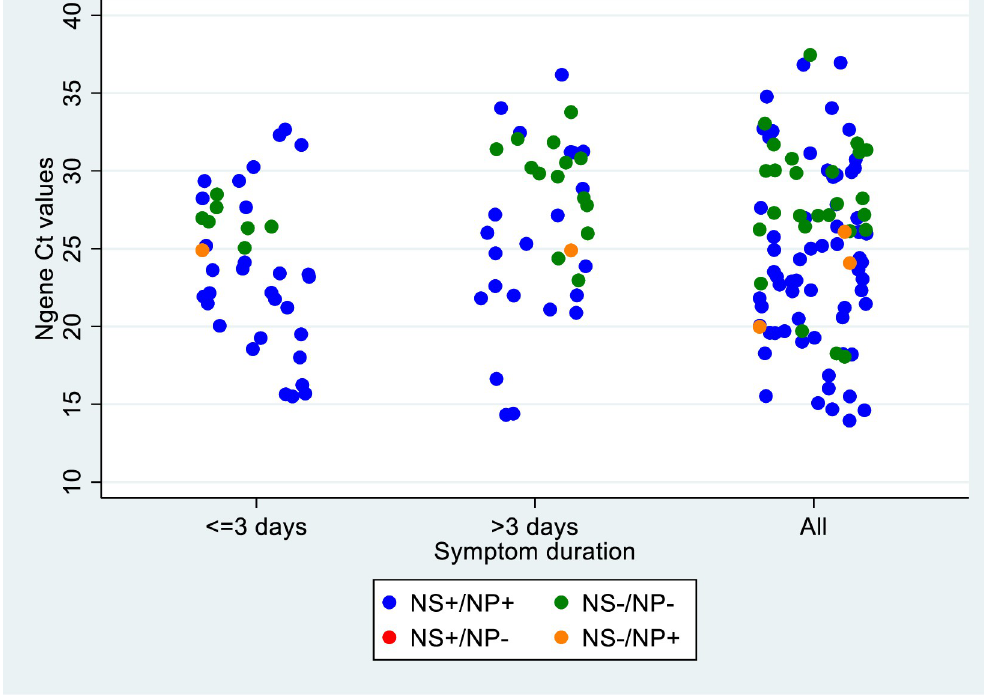
Fig 2. Agreement of nasal and naso-pharyngeal Ag-RDTs by Ct value and duration of symptoms among participants with positive reference test (nasopharyngeal PCR). The graph includes in total 92 out of the 124 participants with positive PCR. 12 had a positive PCR from Xpert (no Ct value reported), 20 had nasal, nasopharyngeal or both Ag-RDTs missing.